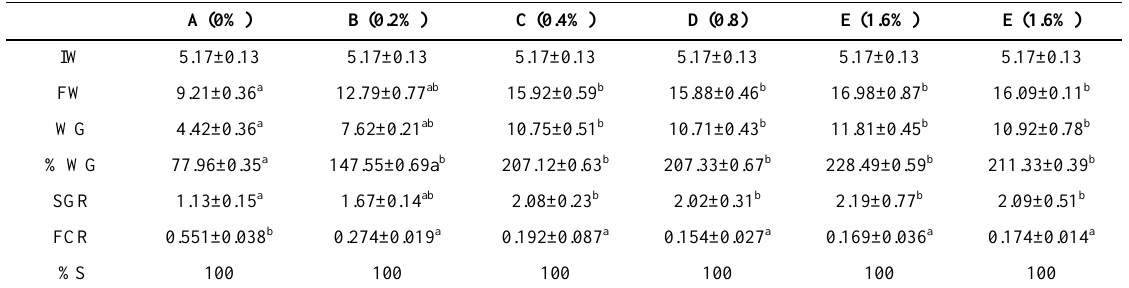
Table 3. Growth performance of silver carp fed experimental diets contain six levels of Choerospondias axillaris (Lapsi